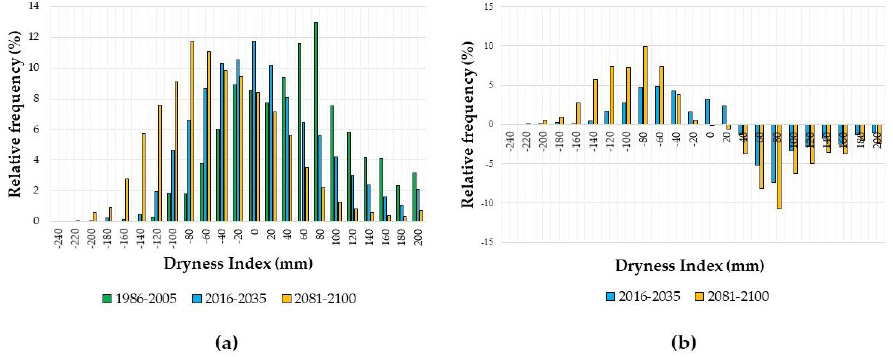
Figure 6. Frequency distribution of the dryness index (DI) in Hungary during the growing season in the three investigated periods ( a ) and changes of these frequencies from the 1986 – 2005 reference period to the near (2016 – 2035) and distant (2081 – 2100) future periods ( b ).